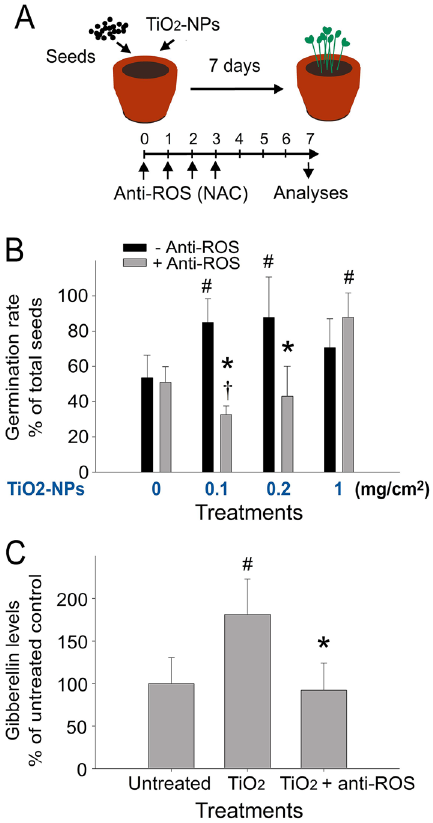
Figure 7. TiO 2 NP-mediated enhancement on the seed germination is associated with ROS-modulated levels of the plant hormone gibberellins. Experimental outline ( A ), the seed germination rate with or without anti-ROS agent NAC treatments ( B ) and the expression levels of plant hormone gibberellins ( C ) are showed. # P < 0.05 vs. 0 mg/cm 2 TiO 2 untreated groups ( B,C ); * P < 0.05 vs. respective without anti-ROS treatment groups (-anti-ROS) (B); † P < 0.05 vs. TiO 2 groups. n = 3 (3 independent experiments; each experiment with 30 seeds) (B); n = 3 (3 independent experiments; each experiment with 80